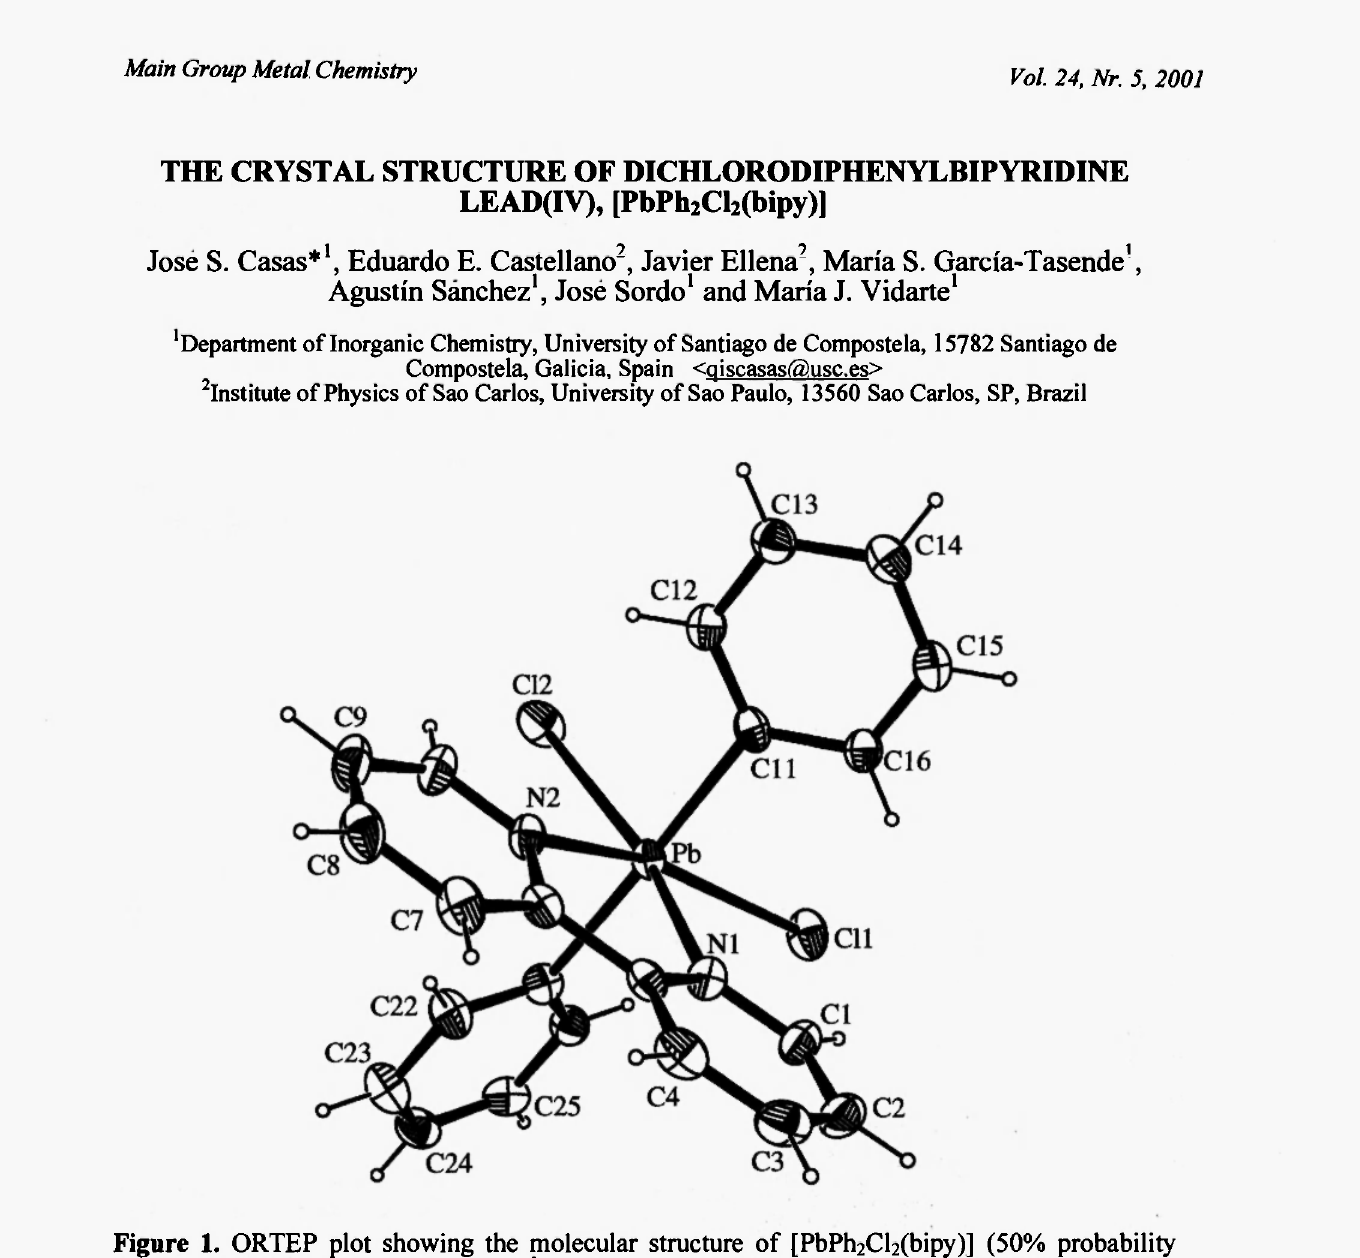
Figure 1. ORTEP plot showing the molecular structure of [PbPh ellipsoids). Selected bond distances (Ä) and angles (°): Pb-C(ll) 2.189(4), Pb-C(21) 2.208(5), Pb-N(l) 2.507(4), Pb-N(2) 2.515(4), Pb-Cl(l) 2.6355(12), Pb-Cl(2) 2.6583(12), C(11)-Pb-C(21) 176.86(17), C(ll)-Pb-N(l) 88.09(15), C(21)-Pb-N(l) 90.88(15), C(ll)-Pb-N(2) 87.38(14), C(21)-Pb-N(2) 89.49(15), N(l)-Pb-N(2) 65.71(12), C(ll)-Pb-Cl(l) 90.46(12), C(21)-Pb-Cl(l) 92.48(13), N(l)-Pb-Cl(l) 88.27(9), C(ll)-Pb-Cl(2) 90.85(13), C(21)-Pb-Cl(2) 89.05(13), N(2)- Pb-Cl(2) 93.32(10), Cl(l)-Pb-Cl(2) 112.68(4).